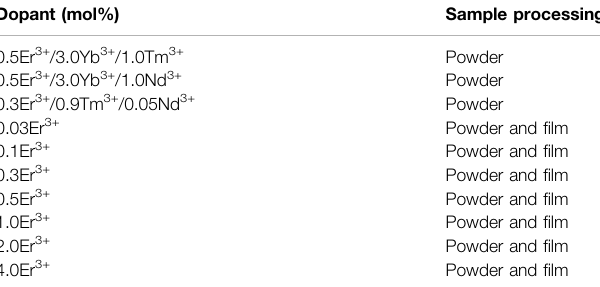
TABLE 1 | Triply doped and Er 3+ -doped SiO 2 -Ta 2 O 5 nanocomposites and fi lms. Dopant (mol%) Sample